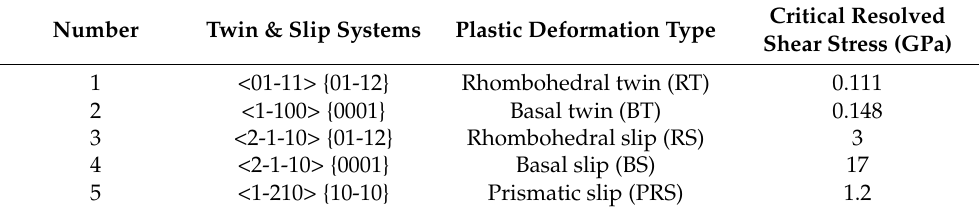
Table 1. The twin and slip systems of sapphire at room temperature [28].